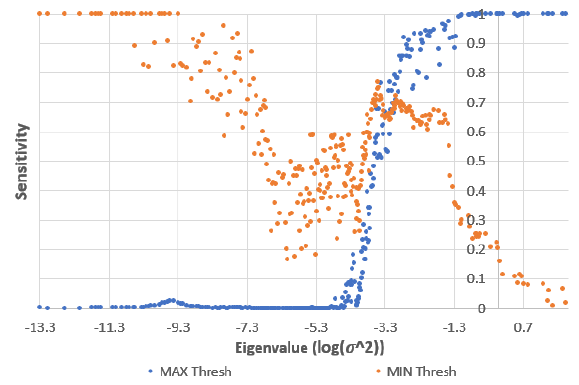
Figure 3. Sensitivity measurements in relation to dif- ferent eigenvalue